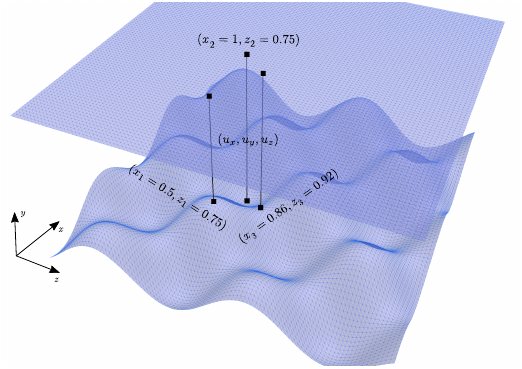
Figure 15. Definition of the 1D profiles used for the comparison with